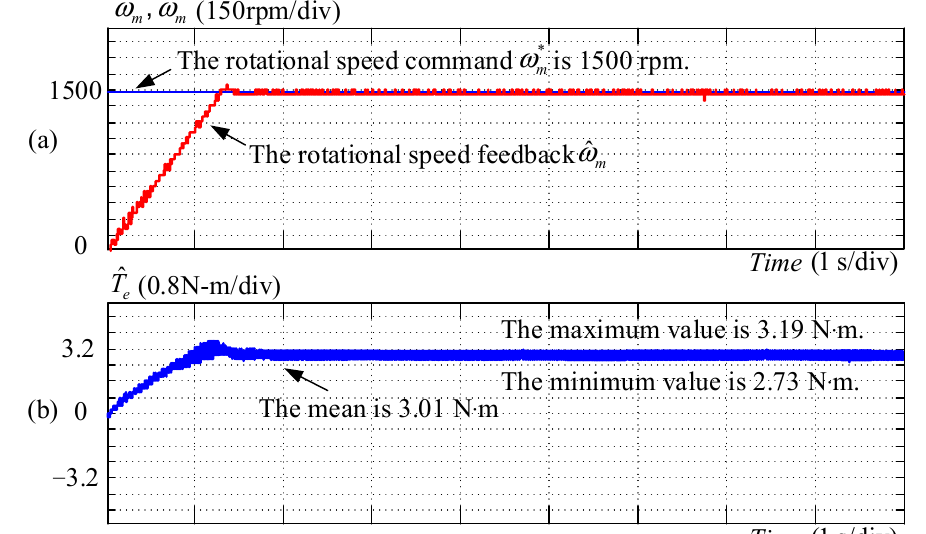
Figure 9. Measured rotational speed and electromagnetic torque of a three-phase permanent-mag- net synchronous motor driven at 1500 rpm without compensation for harmonic components in induced EMF: ( a ) measured rotational speed command ω ∗ m and rotational speed feedback ˆ ω m ; ( b ) measured electromagnetic torque ˆ T e .